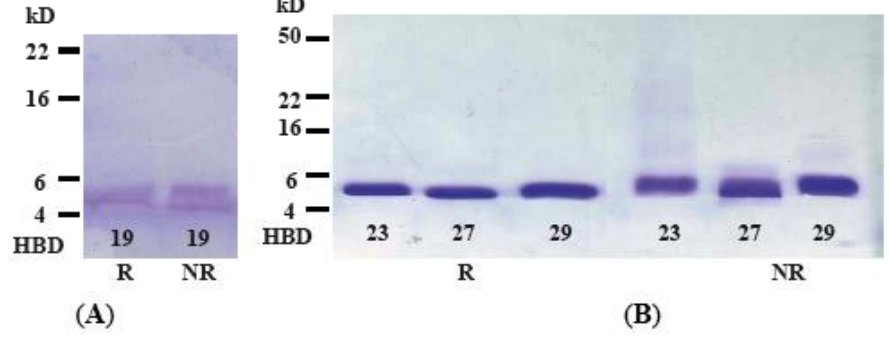
Figure 2. SDS-PAGE analysis of refolded synthetic human  -defensins. ( A ) HBD-19 and ( B ) HBD-23, HBD-27 and HBD-29 were examined in reduced (R) and non-reduced (NR) states by SDS-PAGE on 15% polyacrylamide gels followed by staining with Commassie blue